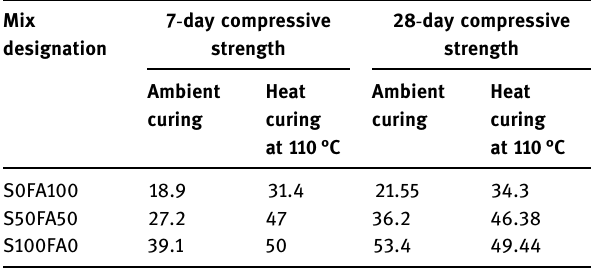
Table 6: The compressive strength of SCGC specimens Mix